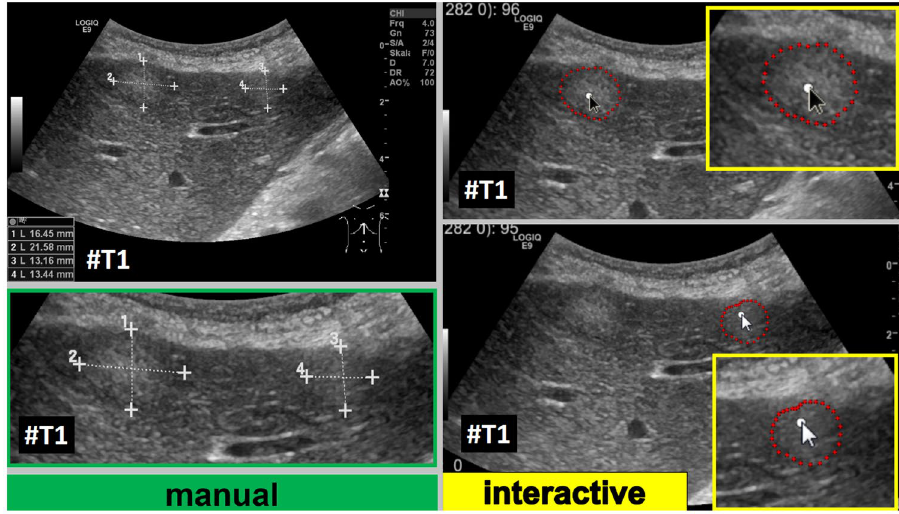
Figure 10. Direct side-by-side comparison of the interactive segmentation results for the two colon cancer liver metastases from Fig. 9 (right side) and a manual expert measurement of the metastasis (left side). Note: figure adapted from 26 .